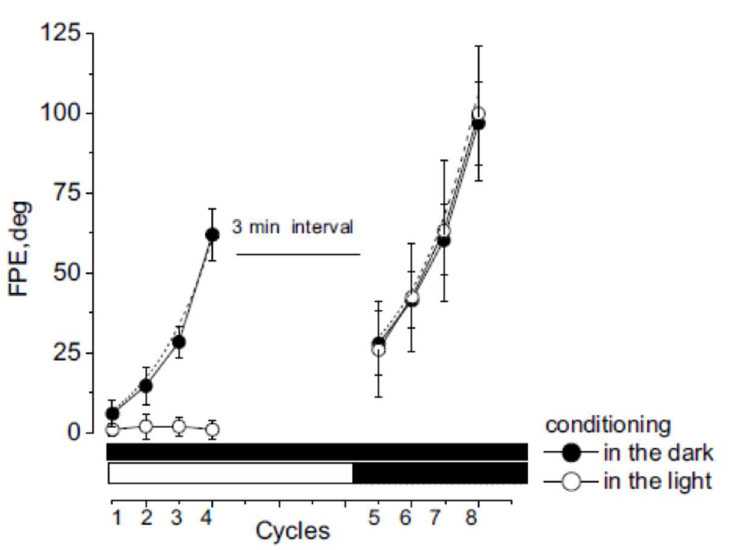
Figure 3. Tracking of the remembered target during cycles of asymmetric rotation (session 1 and 2). Left graph: four cycles of conditioning; right graph: four cycles of testing. Amplitude of final position error with conditioning in the dark (filled circles) and in the light (open circles). Data are reported as mean and SD. Dashed line represents the exponential fit. Bars below indicate the lighting condition during conditioning and testing: black indicates dark and white indicates light.